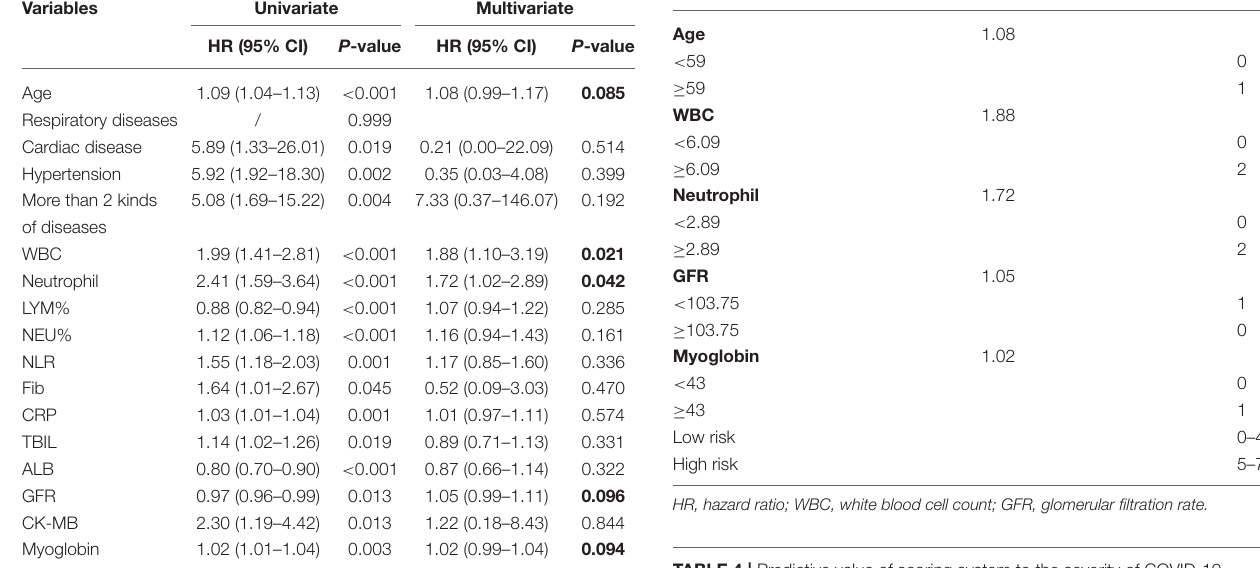
TABLE 4 | Predictive value of scoring system to the severity of